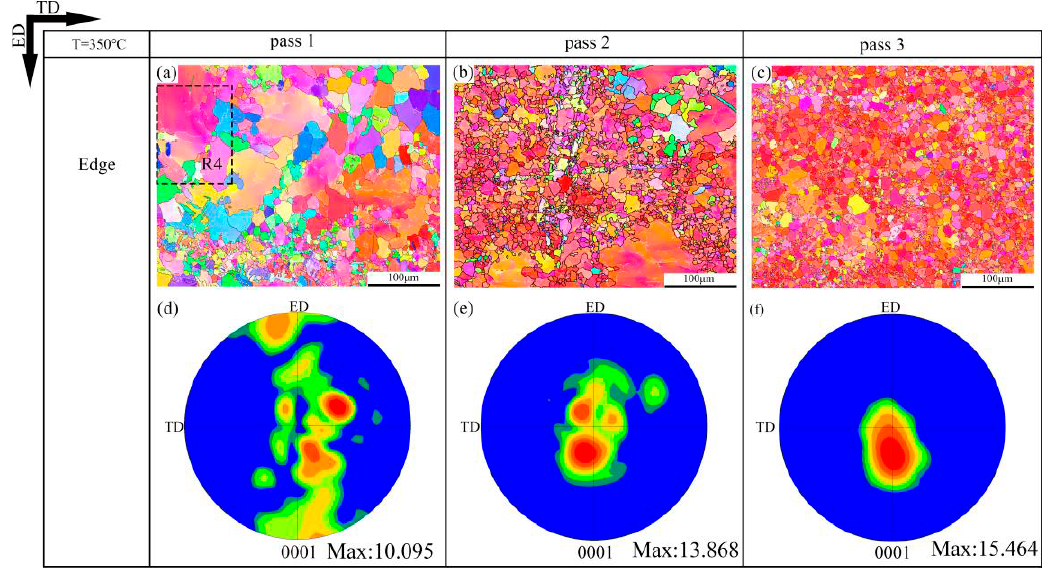
Figure 7. The EBSD inverse pole figure maps and (0001) pole figure maps of the CEE-AEC samples at 350 ◦ C: ( a ) IPF map of Edge pass 1; ( b ) IPF map of Edge pass 2; ( c ) IPF map of Edge pass 3; ( d ) The corresponding (0001) pole figure in ( a ); ( e ) The corresponding (0001) pole figure in ( b ); ( f ) The corresponding (0001) pole figure in ( c ).